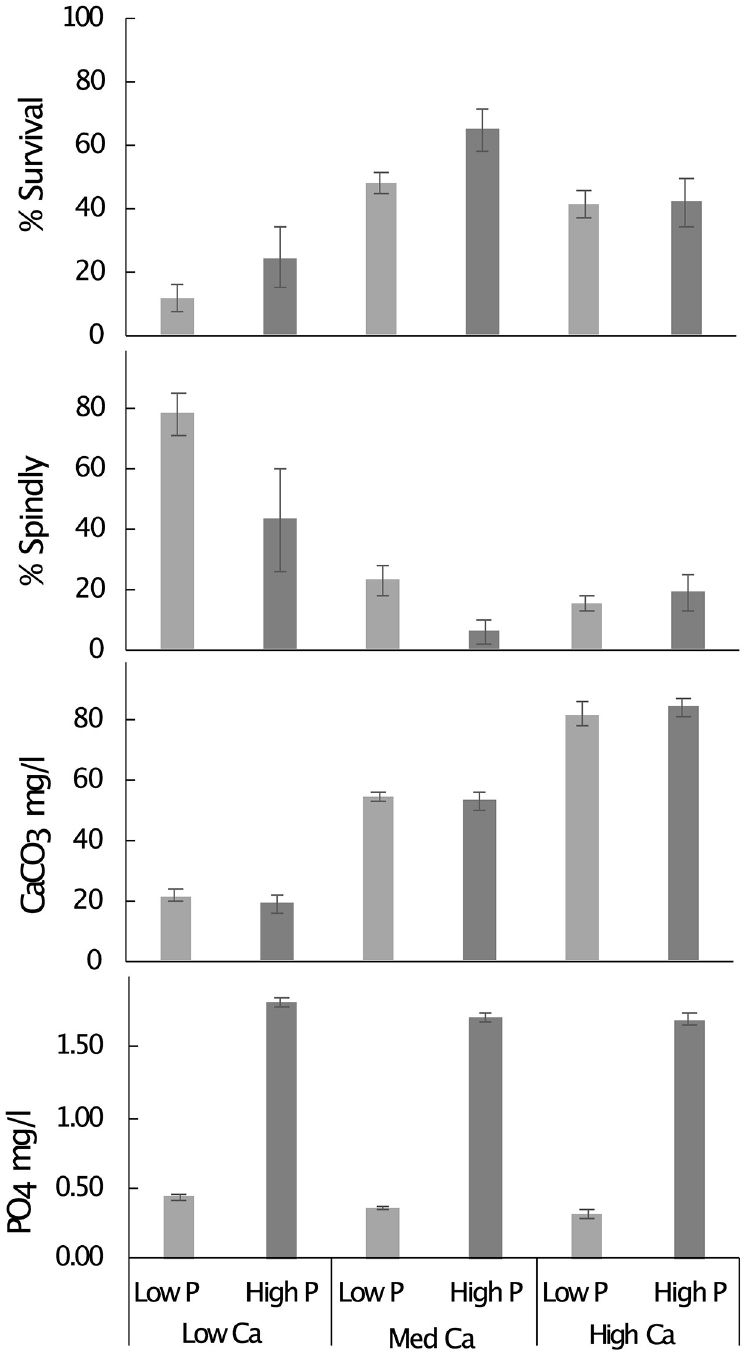
Fig 2. Effects of phosphate and calcium on survival to metamorphosis and prevalence of spindly leg syndrome among surviving Atelopus varius metamorphs. Shown are means +/- SE (bars). Each treatment was replicated in 5 tanks of 20 tadpoles, CaCO 3 and PO 4 was measured monthly in each tank for 4 months.